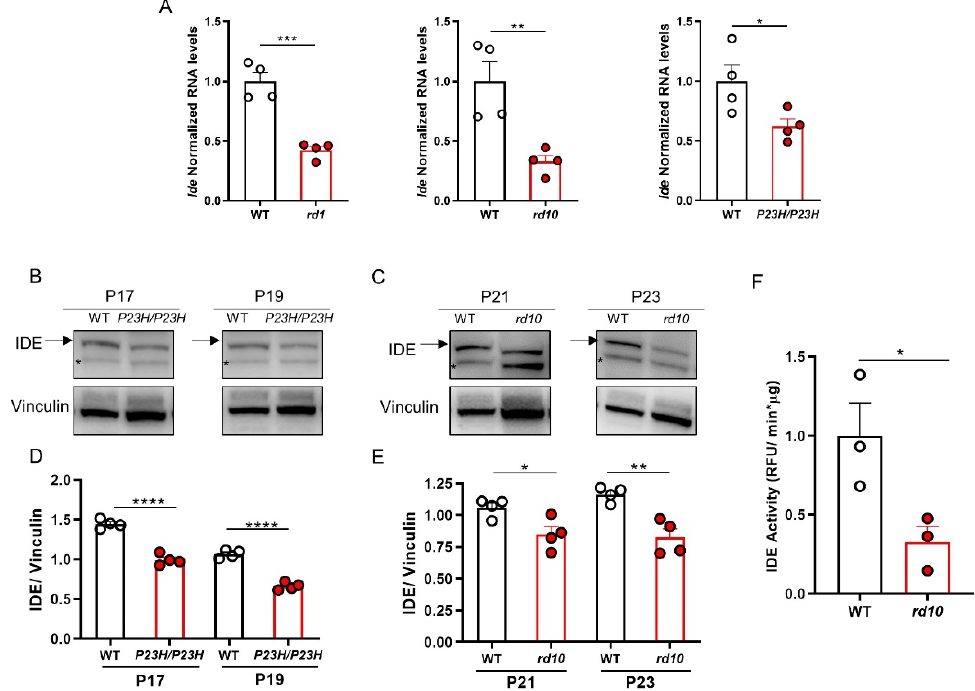
Figure 3. Comparison of retinal IDE levels in wild-type mice and mouse models of retinitis pigmentosa. ( A ) RT-qPCR of individual retinas from WT and rd1 mice at P11, WT and rd10 mice at P21, and WT and P23H/P23H mice at P14. Ide transcript levels were normalized to Tbp RNA levels and expressed relative to corresponding WT levels (assigned a value of 1). Results represent the mean + SEM. n = 4 individual retinas from 4 mice. *** p < 0.001; ** p < 0.01; * p < 0.05 (unpaired 2-tailed Student’s t -test). ( B , C ) Representative images showing Western blots of individual retinas from WT and P23H/P23H ( B ) or WT and rd10 ( C ) mice at the indicated ages. Arrow indicates the 110 kDa band corresponding to IDE, and asterisk indicates a non-specific band, previously described by Fern á ndez-D í az et al. [19]. ( D , E ) Densitometric analysis of Western blot images. Levels of IDE were normalized to those of vinculin. Results represent the mean + SEM. n = 4 individual retinas from 4 mice, **** p < 0.0001; ** p < 0.01 (2-way ANOVA). ( F ) IDE activity as measured by fluorometric assay of WT and rd1 0 retinas at P23. Results represent the mean + SEM. n = 3 mice. * p < 0.05 (unpaired 2-tailed Student’s t -test).